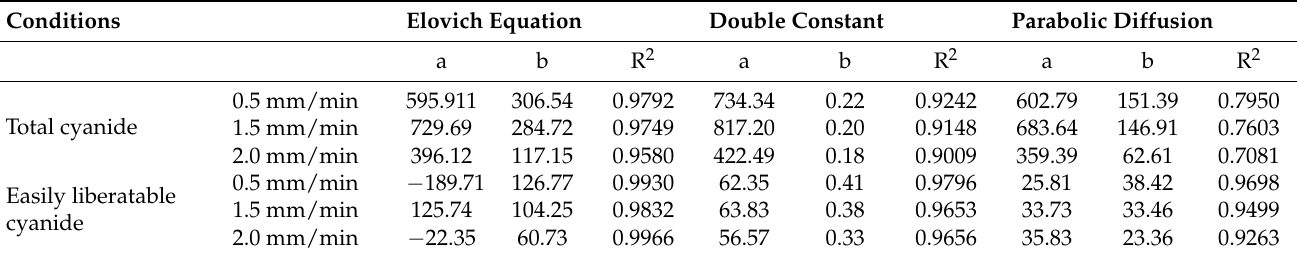
Figure 6. Linear regressions between ( a ) ln(Qe − Qt) and ( b ) t/Qt of accumulation release amount for easily liberatable cyanide.